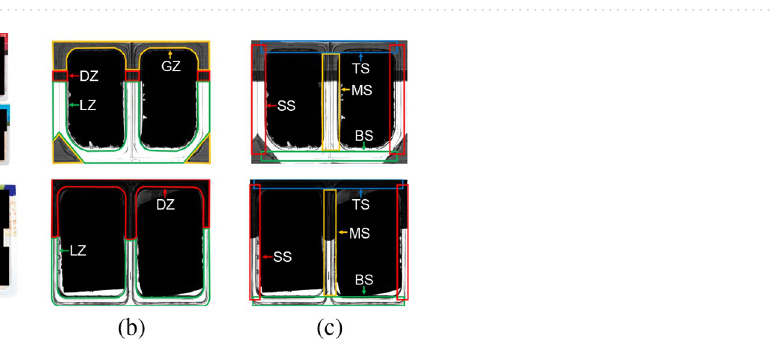
Fig. 3(c) and correspond to top sealing (TS), bottom sealing (BS), side sealing (SS), and middle sealing (MS), the latter appearing only in bi-pack packages.